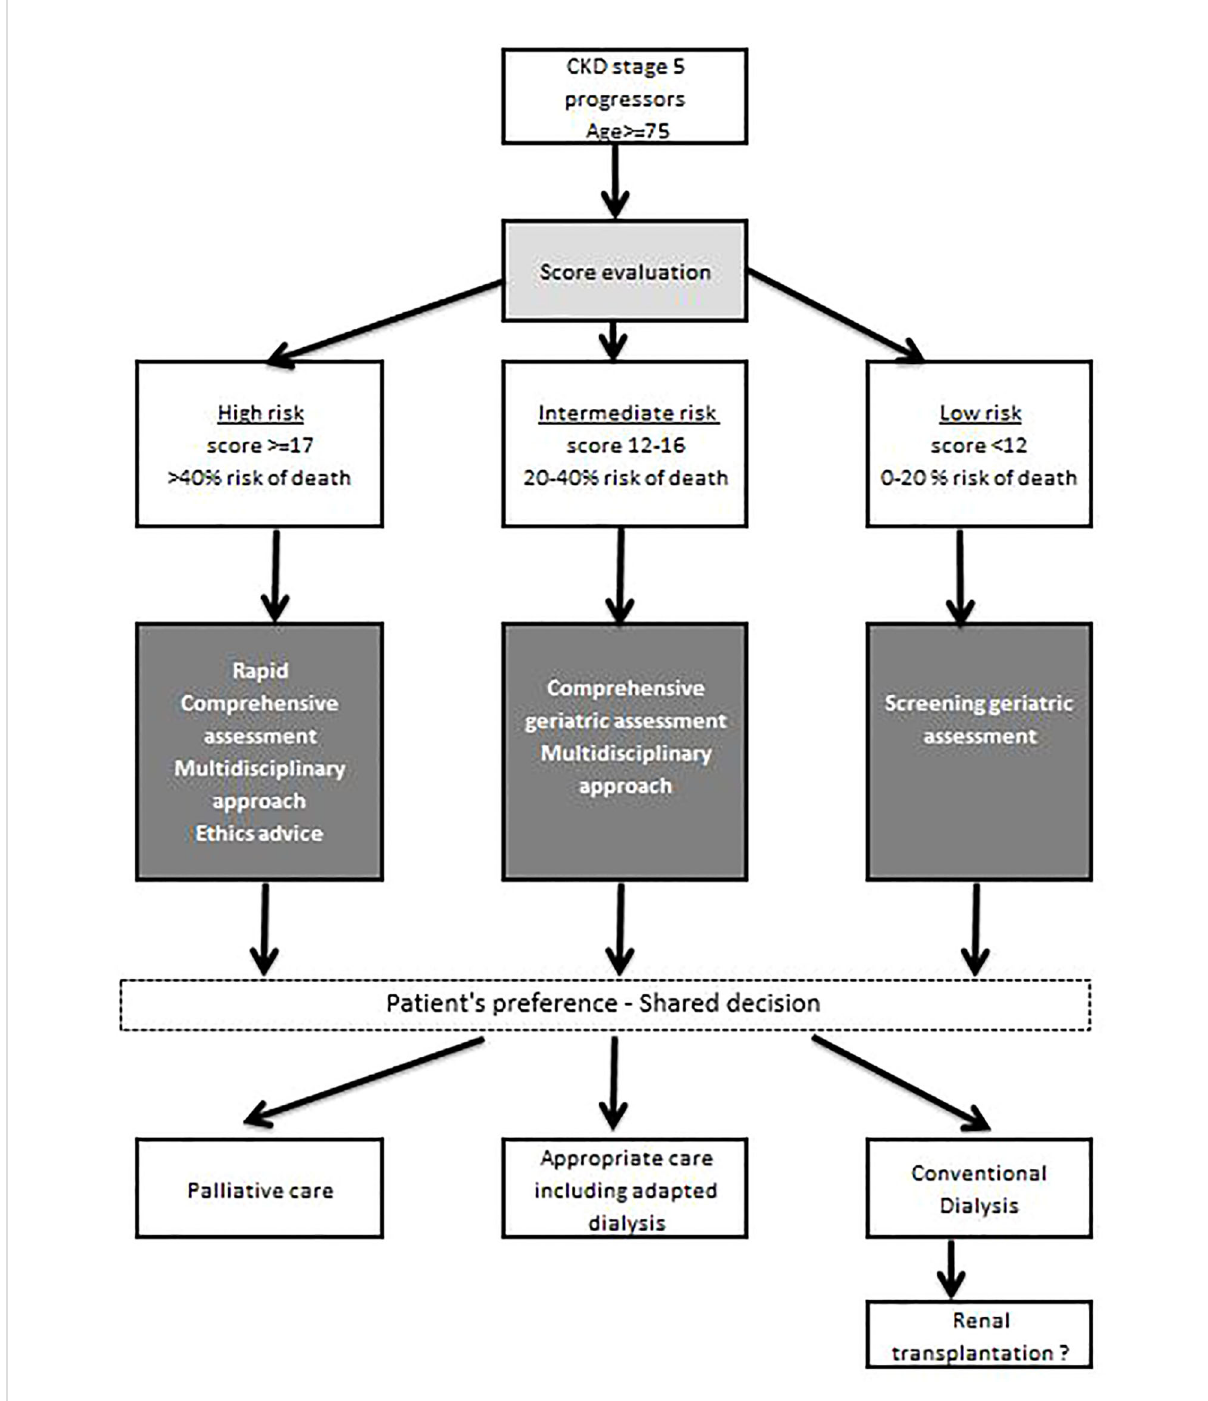
FIGURE 6 Proposed risk strati fi cation algorithm to screen for, evaluate and decide on an appropriate care strategy for older ESKD patients, according to their level of risk of early death (source REIN registry). Adapted from Couchoud et al., 2015